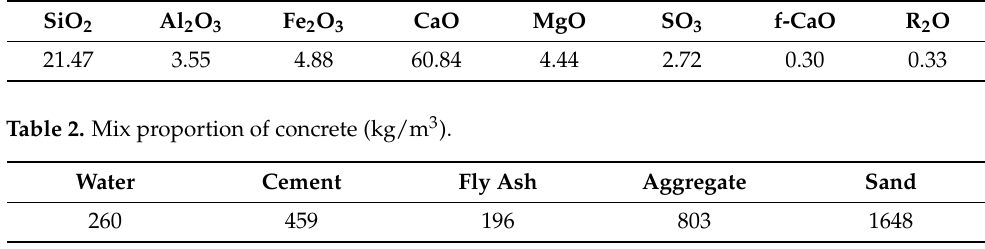
Table 1. Chemical composition of cement (%).